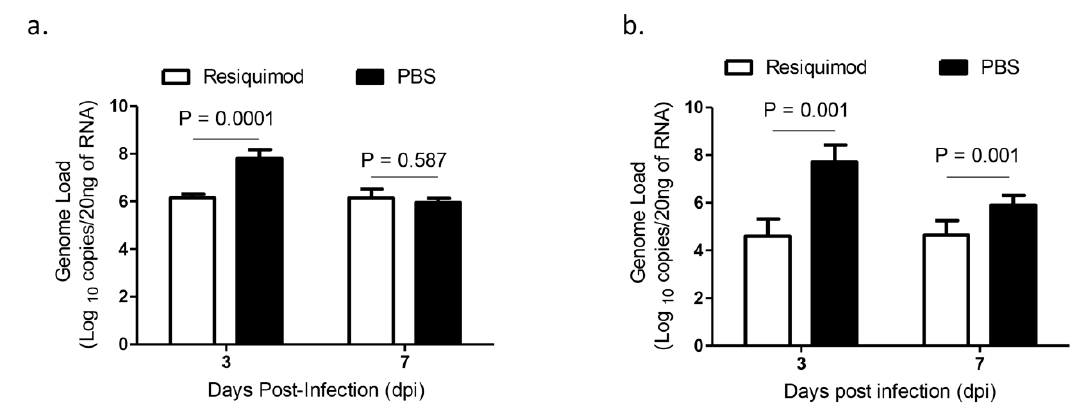
Figure 3. Infectious bronchitis virus (IBV) shedding via oropharyngeal and cloacal routes following infection with IBV M41 in in ovo resiquimod pretreated chickens. ED18 SPF eggs were treated with resiquimod (n = 10, 400 µ g of resiquimod in 200 µ L of PBS per egg) or PBS (n = 15, 200 µ L of PBS per egg) and incubated to hatch. On the day of hatch, the chickens were infected with IBV M41 intratracheally. On 3 and 7 dpi ( a ) oropharyngeal and ( b ) cloacal swabs were used for the extraction of RNA and real-time PCR assay was used for the IBV genome quantification. Linear mixed-e ff ects model followed by a pairwise comparison using Tukey’s test was used to identify group di ff erences in oropharyngeal and cloacal IBV genome loads. The di ff erences were considered significant at p ≤ 0.001. The error bars represent ±